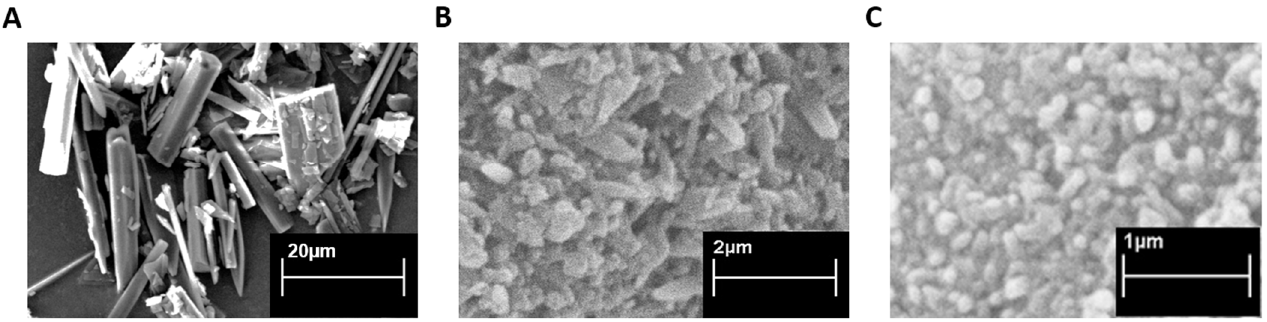
Figure 2. SEM images of raw resveratrol ( A ), trans -resveratrol nanocrystals ( B ) and lipid-coated nanocrystals ( C ).